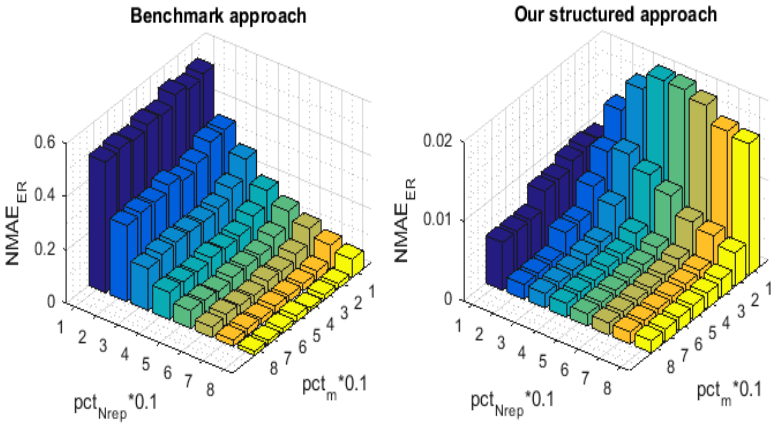
Figure 8. NMAE ER for the proposed technique and for the